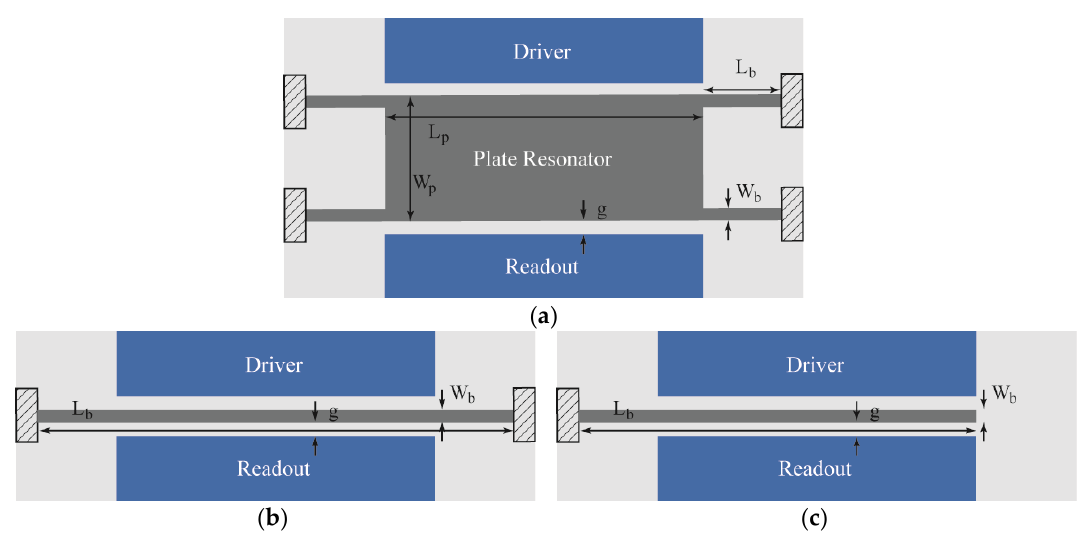
Figure 1. Schematics showing the three geometries analyzed in this work: ( a ) Plate-shaped resonators with two different sizes denoted as Plate-B1 and Plate-B2; ( b ) CC-Beam resonator; and ( c ) Cantilever resonator. The figure also shows, colored in dark blue, the driver-readout scheme composed by two electrodes for electrostatic actuation and capacitive readout.